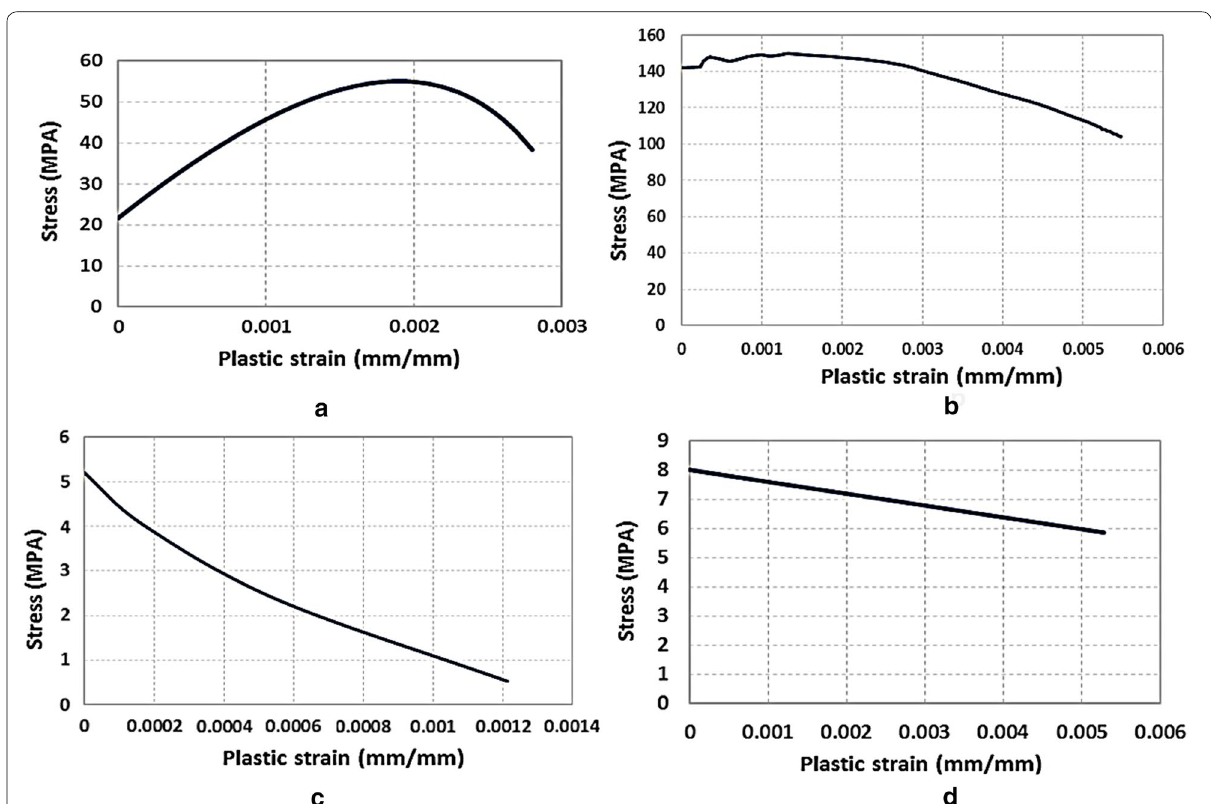
Fig. 9 Nonlinear behaviour of materials: a normal concrete in compression b normal concrete in tension c UHPC in compression d UHPC in